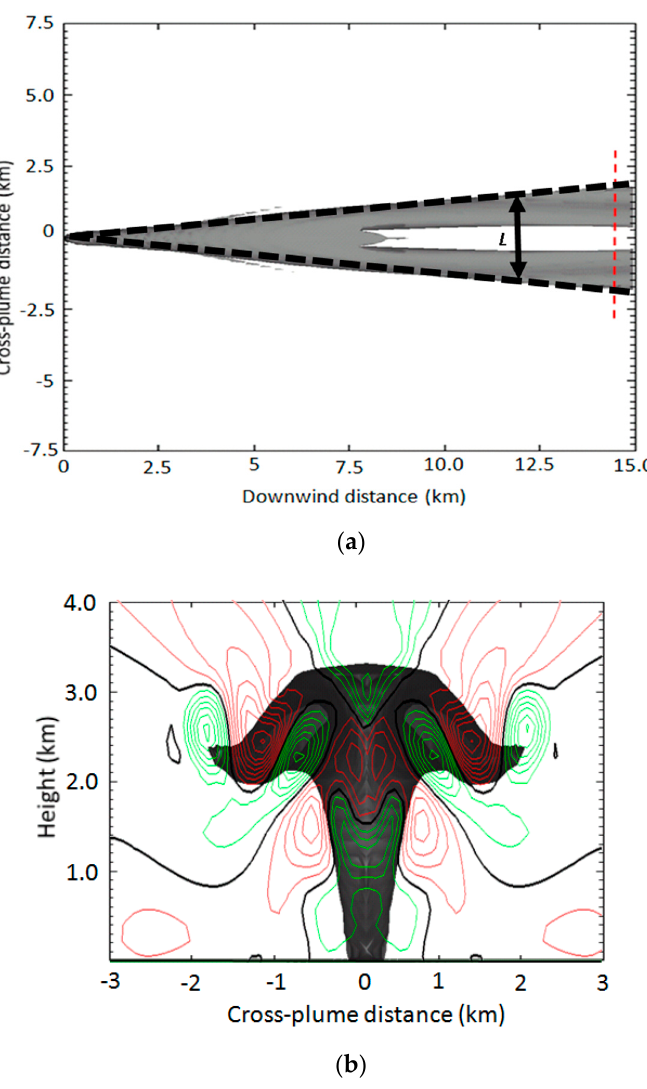
Figure 11. ( a ) Iso-surface of concentration at t = 1200 s for background wind speed of 5 ms − 1 looking down on the plume. The straight black dotted line shows the near-linear spread of the plume edge, the distance L being a near-linear function of downwind distance; the red dotted line corresponds to the cross section shown in Figure 11b. ( b ) A cross-section through the plume, in the plane with normal aligned with the wind direction, indicated by the red-dashed line in Figure 11a. The area within an iso-surface of concentration, representing the plume edge, is shaded. Contours of the vertical velocity (red, negative; green, positive; solid black, zero) are shown.